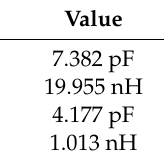
Figure 10. 3D view of the CRLH transmission line unit cell. Table 2. Parameters of the CRLH TL unit cell.